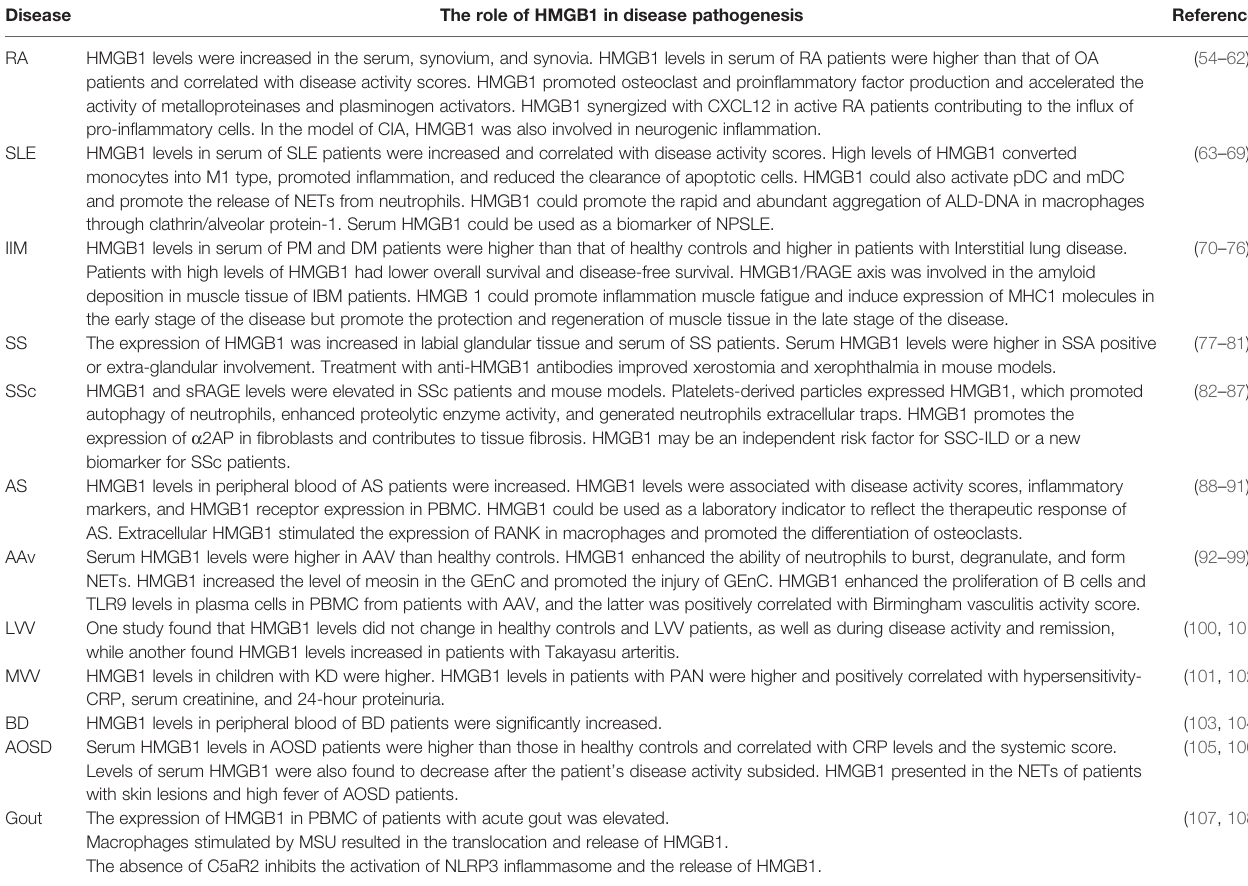
TABLE 1 | The role of HMGB1 in rheumatic